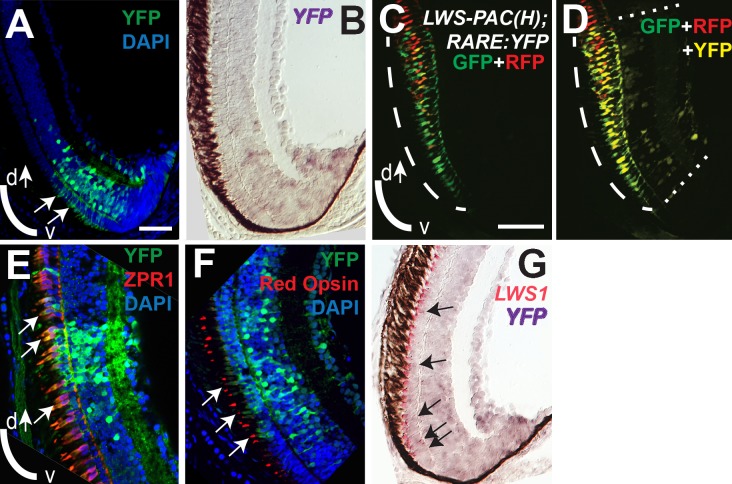
RA signaling continues in juvenile retinas and the signaling domain includes red opsin+, LWS1+ cones.Sections of retina from one-month old fish are shown, with ventral pole at bottom of images. A. Immunocytochemistry to reveal YFP signal and DAPI in a section from RARE:YFP retina. Arrows indicate YFP signal in the outer nuclear layer, corresponding to the location of cone photoreceptors. B. In situ hybridization for topaz-YFP mRNA in a section from a RARE:YFP retina. C and D. LWS:PAC(H) were crossed with RARE:YFP and doubly transgenic juvenile retina sections were examined for RFP, GFP, and YFP fluorescence. Although YFP and GFP cannot be fully resolved, the YFP+ signaling domain coincides with the GFP (LWS1) expression domain. The GFP expression domain (reporting LWS1) is designated by dashed arc (C and D), while the YFP domain (reporting RA signaling) is between the dashed straight lines (D). E. Sections from RARE:YFP juvenile retinas were stained with antibodies for YFP, ZPR1 (labels red- and green-sensitive cones), and DAPI; merged image is shown. Colabel of YFP and ZPR1 is yellow. Arrows indicate ZPR1+ cones that are YFP+. F. Sections from RARE:YFP juvenile retinas were stained with antibodies for YFP, red opsin (pan-LWS), and DAPI; merged image is shown. Arrows indicate red opsin+ cone outer segments that are continuous with YFP+ cell bodies. G. Dual in situ hybridization for topaz-YFP (purple) and LWS1 (red/pink) mRNA in a section from one-month old RARE:YFP retina. Arrows indicate examples of some of the colabeled cones. Scale bar in A = 25 μm; scale bar in C (applies to B-G) = 25 μm; v, ventral; d, dorsal.